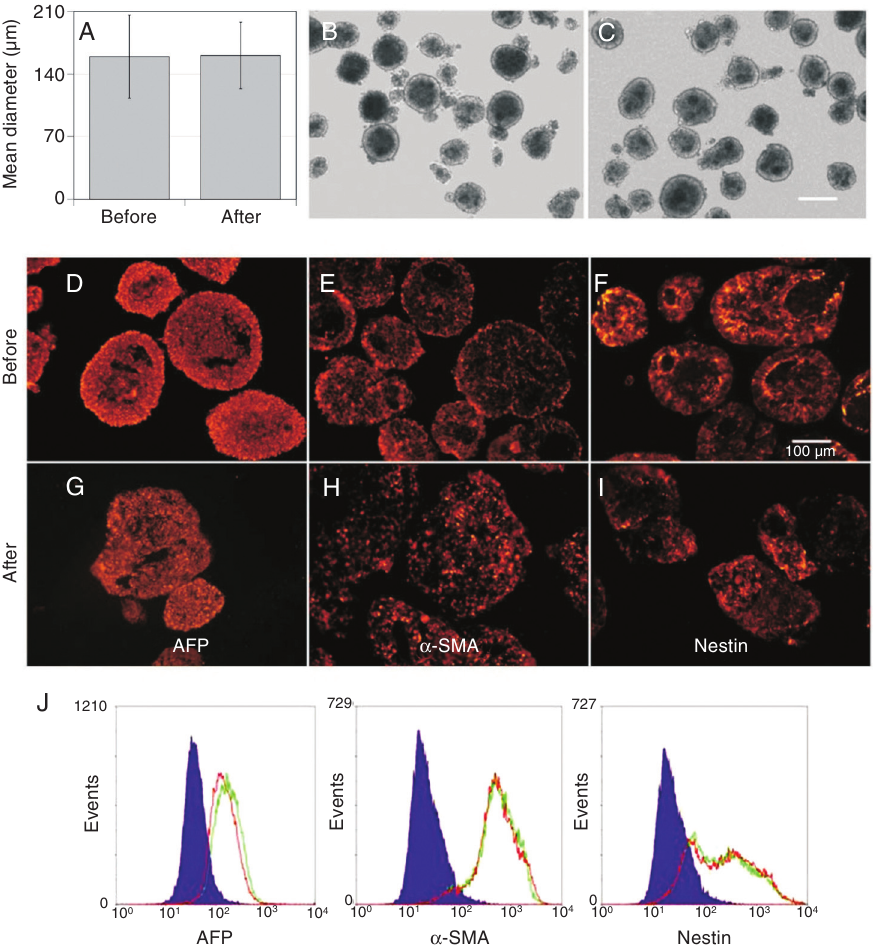
Figure 3. Karyotype analysis of cells after culture in the microcarrier-bioreactor system. Chromosomes were stained with Giemsa and show a normal